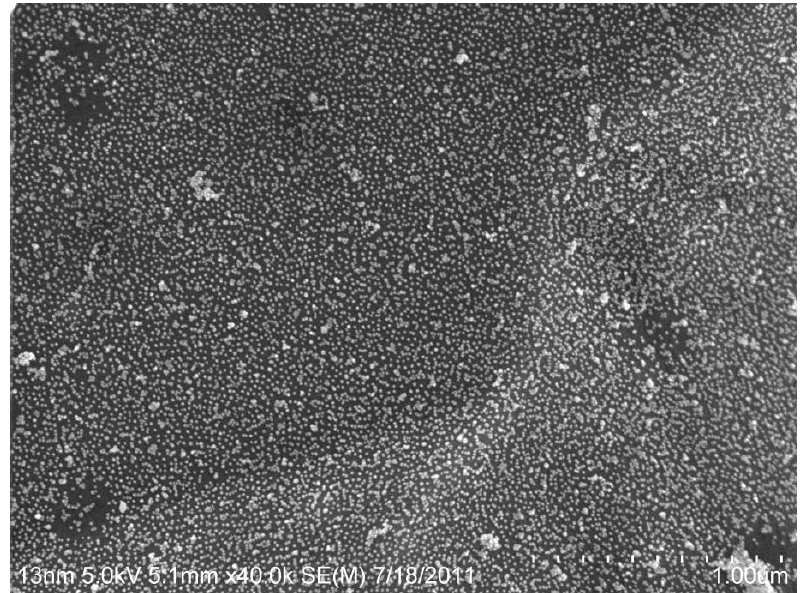
Figure 6. Scanning electron microscopy images of gold nanoparticles immobilized on a surface. We observed consistently-sized gold nanoparticles. The Scale bar is 1 μm.